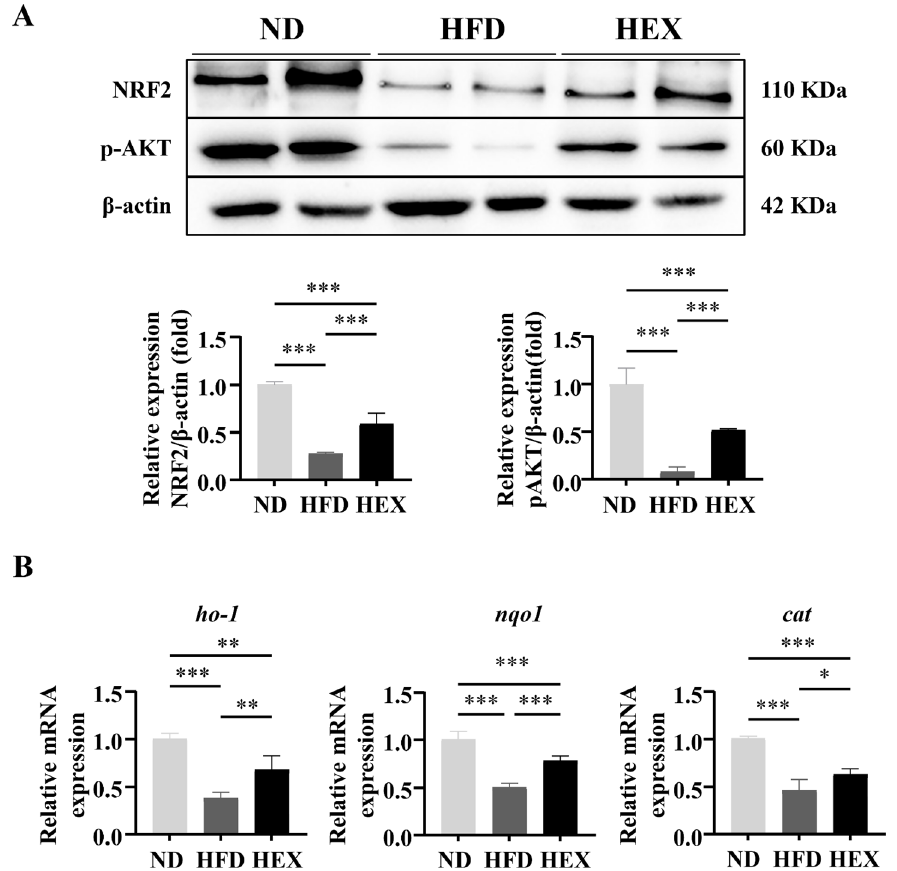
Figure 7. NRF2 signaling in 9-month-old zebrafish livers. ( A ) Western blot of p-AKT and NRF2 expression in zebrafish livers ( n = 8). ( B ) Gene expression of ho-1 , nqo1 , and cat ( n = 6). *, p < 0.05, **, p < 0.01, ***, p < 0.001. Data represent the mean, and error bars represent SEM. NAFLD, non-alcoholic fatty liver disease; ND, normal diet; HFD, high fat diet; HEX, high-fat diet plus exercise.